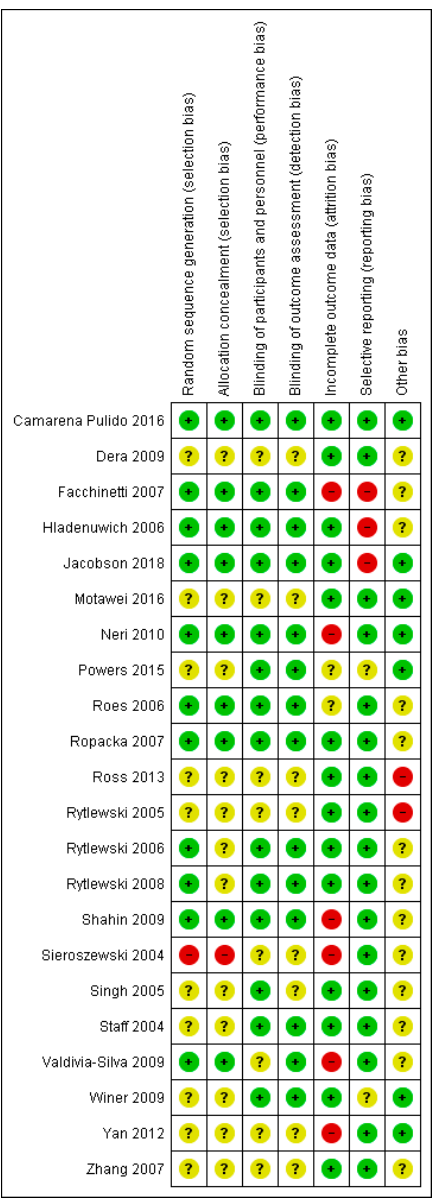
Figure A18. Quality assessment of the included human studies by the Cochrane tool. Quality assessment using the Cochrane risk of bias tool. − = high risk of bias; + = low risk of bias; ? = unclear risk of bias. Table A1. Search terms Pubmed.